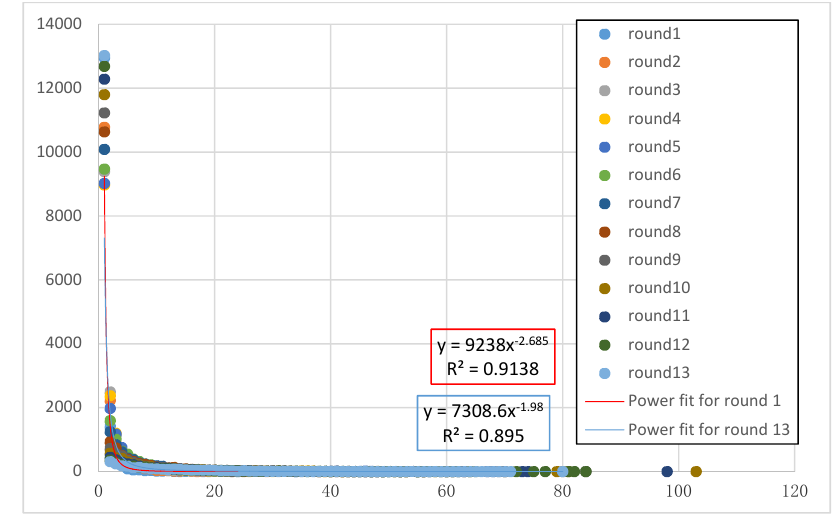
Figure 9. Entropy of all Nls values with different radiuses from round 1 to round 50.